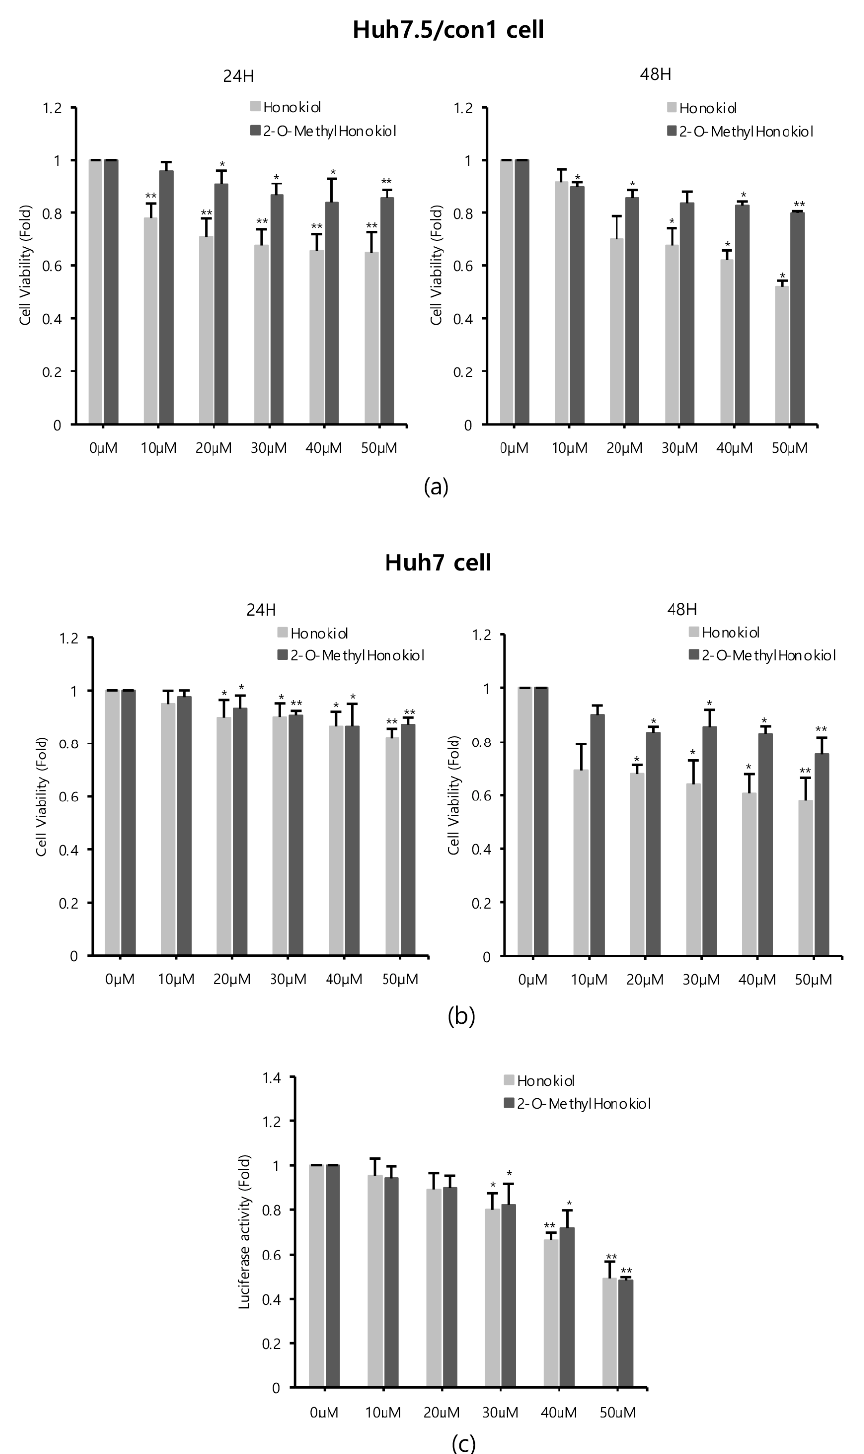
Figure 2. Comparison of 2-O-methylhonokiol and honokiol on cytotoxicity and HCV replication inhibition. ( a ) Huh7.5/Con1 cells and ( b ) Huh7 cells were treated with honokiol and 2-O-mehtylhonokiol at the indicated doses for 24 or 48 h. Cell viability was measured by MTS assay. ( c ) After Huh7.5/Con1 cells were treated with honokiol or 2-O-methylhonokiol at the indicated doses for 24 h, the levels of HCV RNA were measured by Renilla luciferase assay. In each experiment, 0 µ M means a control. The values are shown as the mean ± SD of three independent experiments. * p < 0.05, ** p <0.01 versus untreated